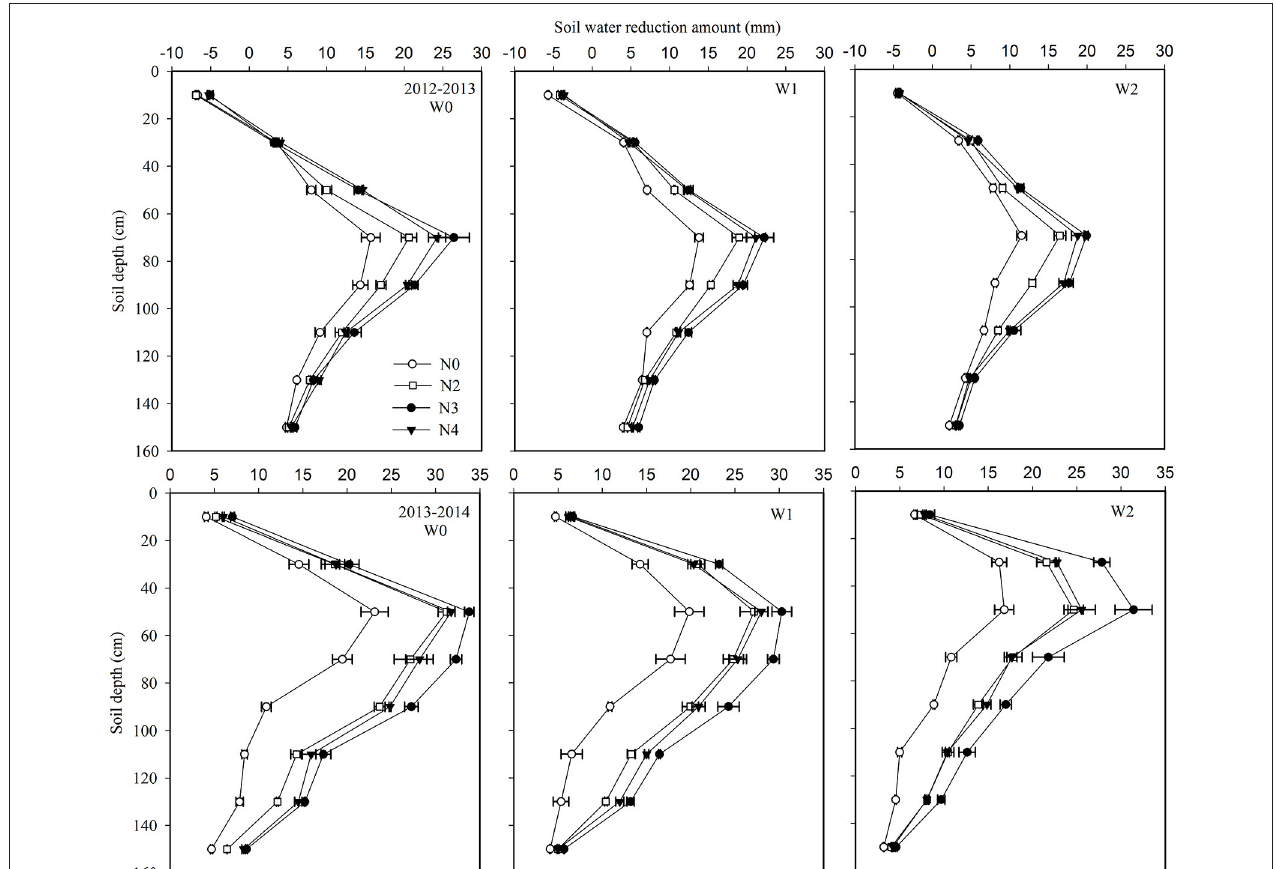
FIGURE 3 | Effects of irrigation and nitrogen regimes on soil water reduction amount at 0.2m soil depth increments to 1.6m in the 2012–2013 and 2013–2014 growing seasons. Horizontal bars represent the standard errors.